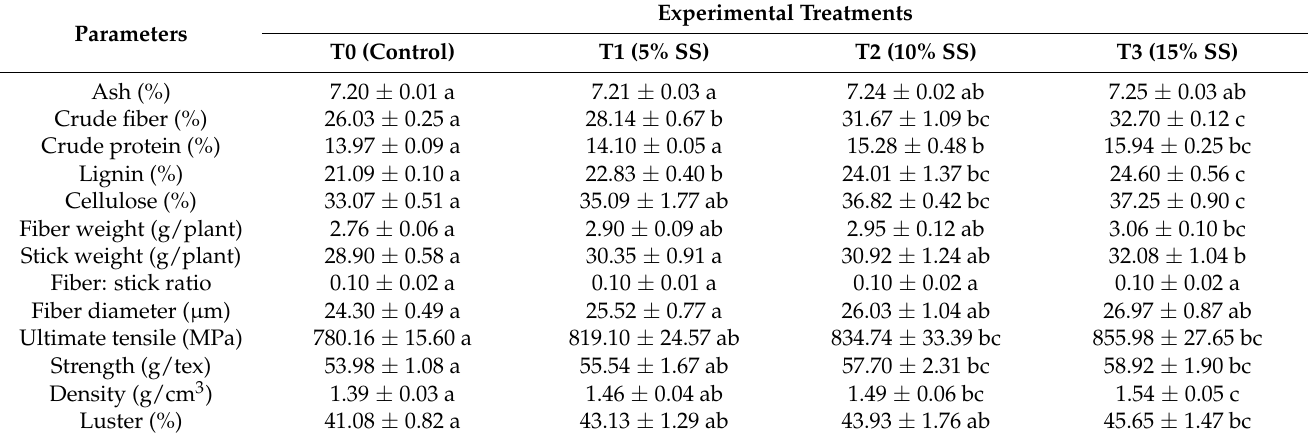
Table 4. Effects of different loading rates of sewage sludge on the proximate and fiber characteristics of cultivated dhaincha ( S. bispinosa